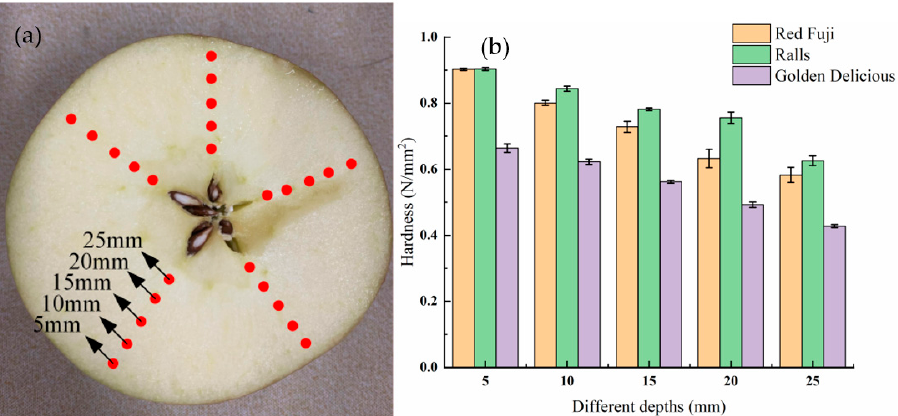
Figure 3. ( a ) Map of apple samples and test point locations; ( b ) bar chart of the hardness distribu- tion of the three kinds of apple at different